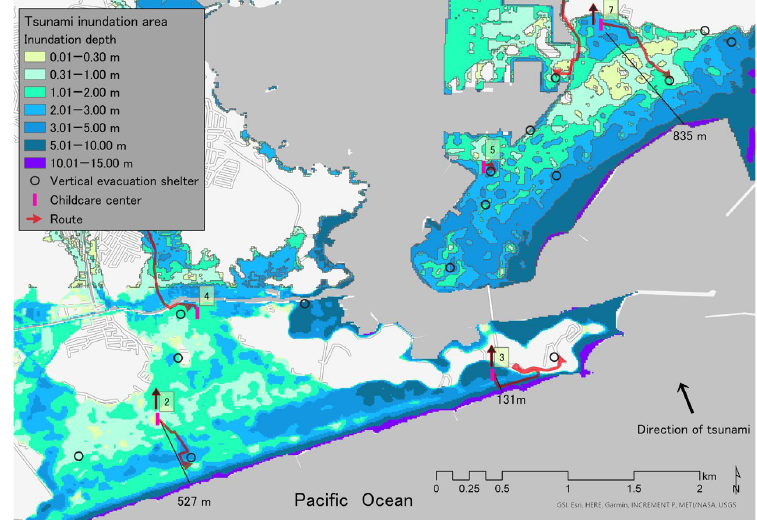
Figure 5. Routes to the nearest vertical evacuation shelter of childcare centers ID1 and ID6 and the direction of rapid evacuation from the tsunami. The direction required for rapid tsunami evacuation is indicated by a black arrow with a red border.